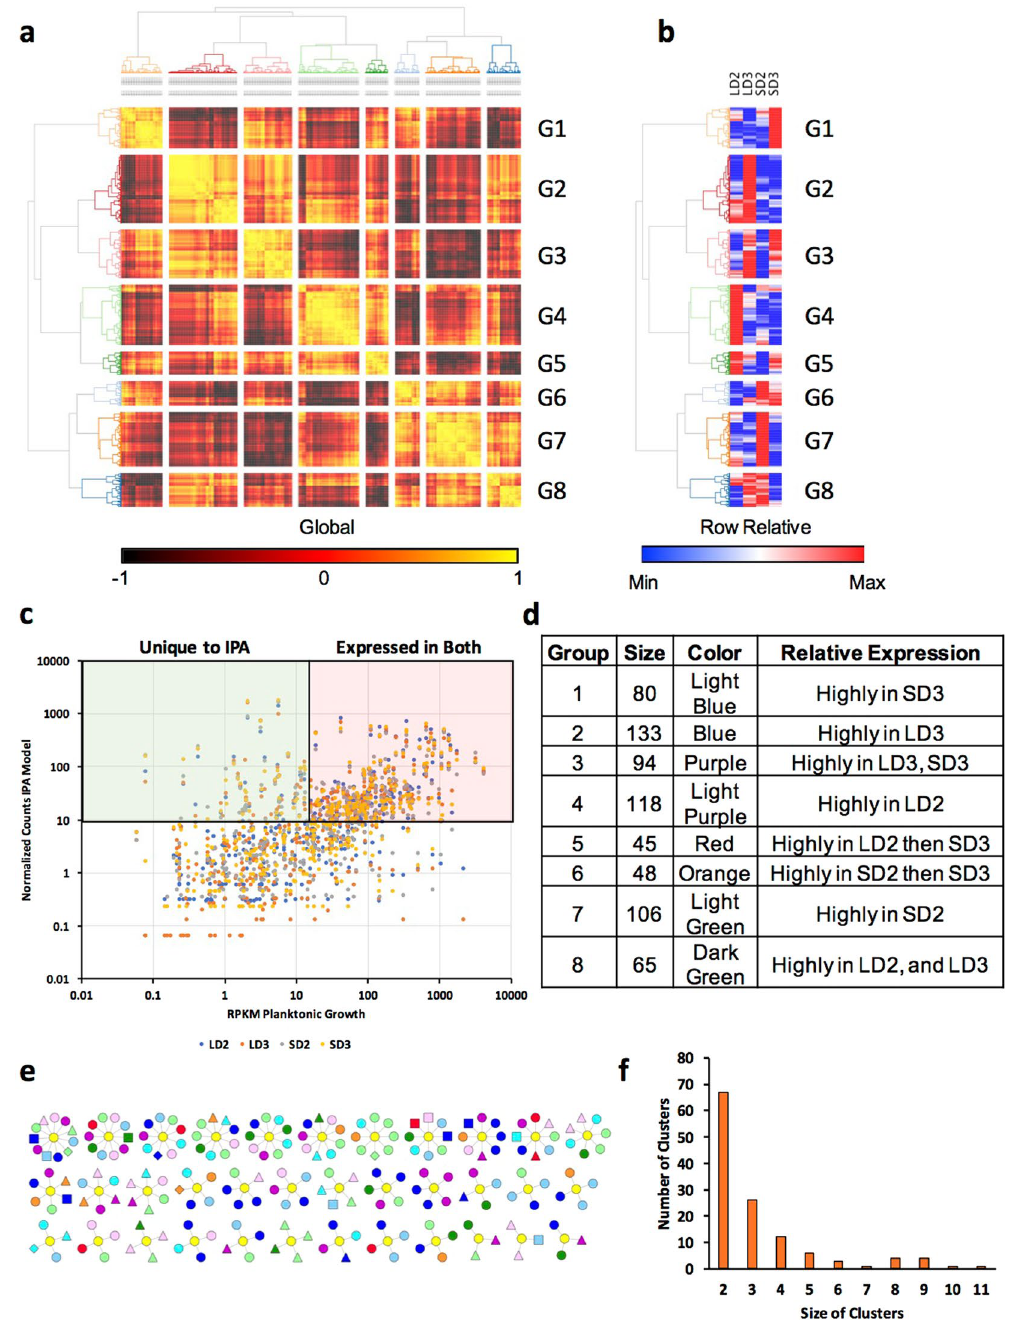
Figure 8. Clustering and expression analysis of the putative secretome from Aspergillus fumigatus . ( a ) Hierarchical clustering of the putative secretome of A. fumigatus Af1163 by gene expression during the steroid and chemotherapeutic models of invasive pulmonary aspergillosis on day 2 and day 3 post inoculation. ( b ) Hierarchical clustering based upon gene expression during the steroid and chemotherapeutic models on day 2 and day 3 post inoculation for the putative secretome of A. fumigatus Af1163. ( c ) Scatter plot of putative secreted protein gene expression (normalized counts) at LD2 (Blue), LD3 (Orange), SD2 (Gray), and SD3 (Yellow) versus expression during planktonic growth (RPKM). ( d ) Summary table of gene expression groupings: size of groupings, color code for clustering, and relative expression. ( e ) Clustering of putative secreted proteins based on sequence similarity. Color of nodes indicate grouping from gene expression ( a,b ) see ( d,e ). ( f ) Distribution of clusters based on size. Steroid Model, S; Chemotherapeutic Model, L; Day 2, D2; Day 3,